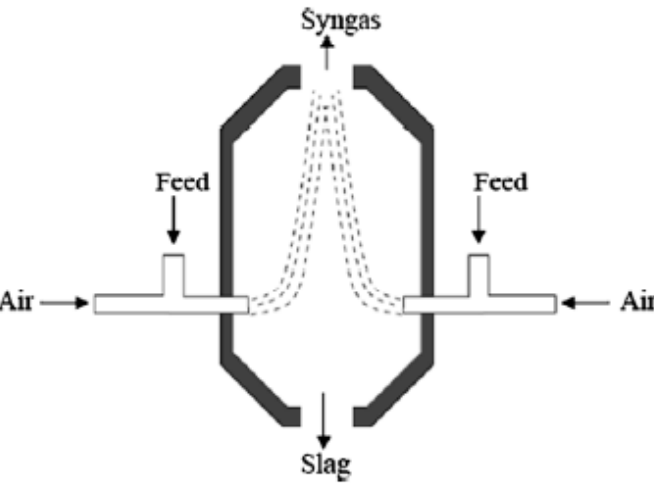
Figure 5. Configuration of an entrained flow gasifier [35,36].